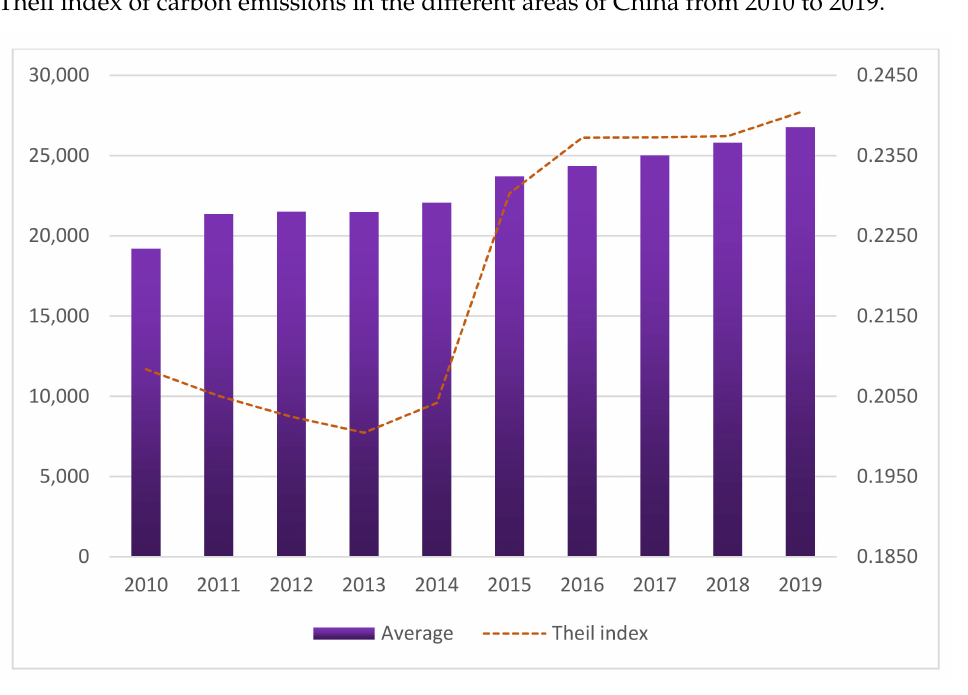
Figure 2. The average and Theil index of carbon emissions in different regions of China from 2010 to